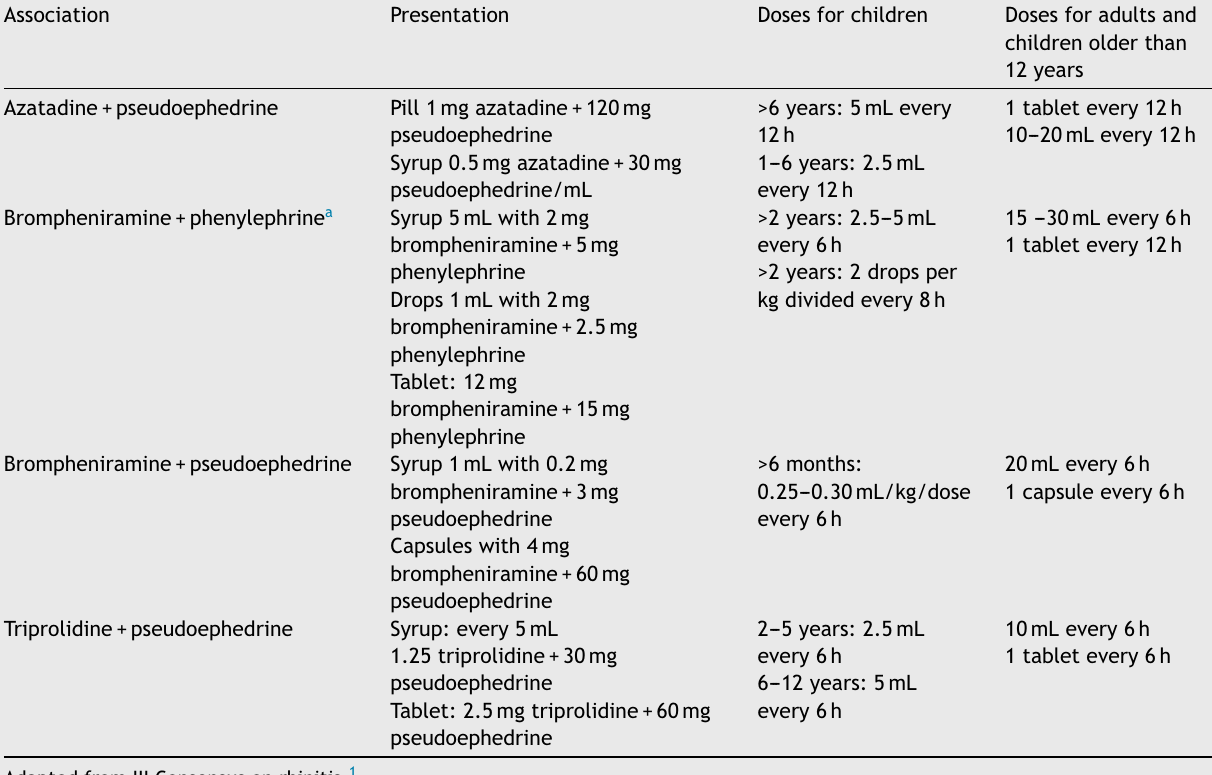
Association of first-generation antihistamines with decongestants. 1